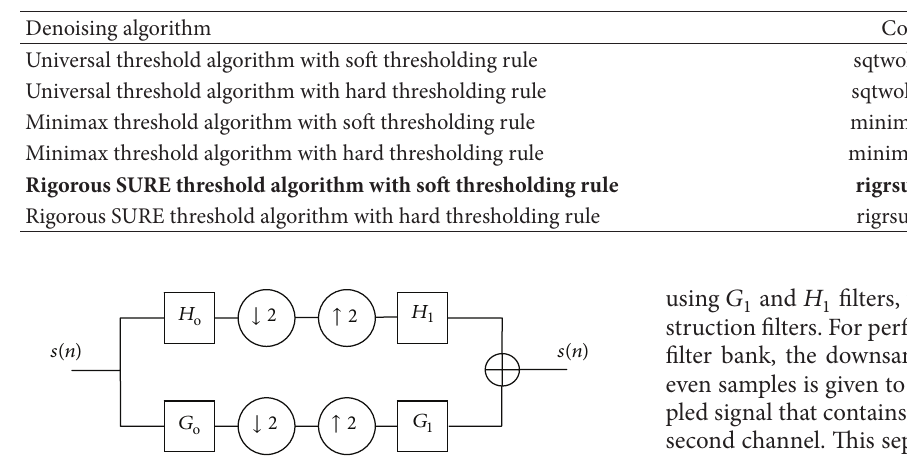
Table 1: Comparison of denoising algorithms.